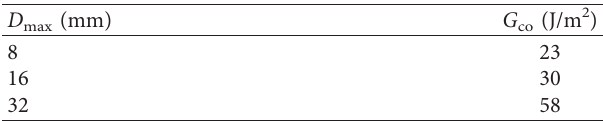
Table 1: Relationship between G